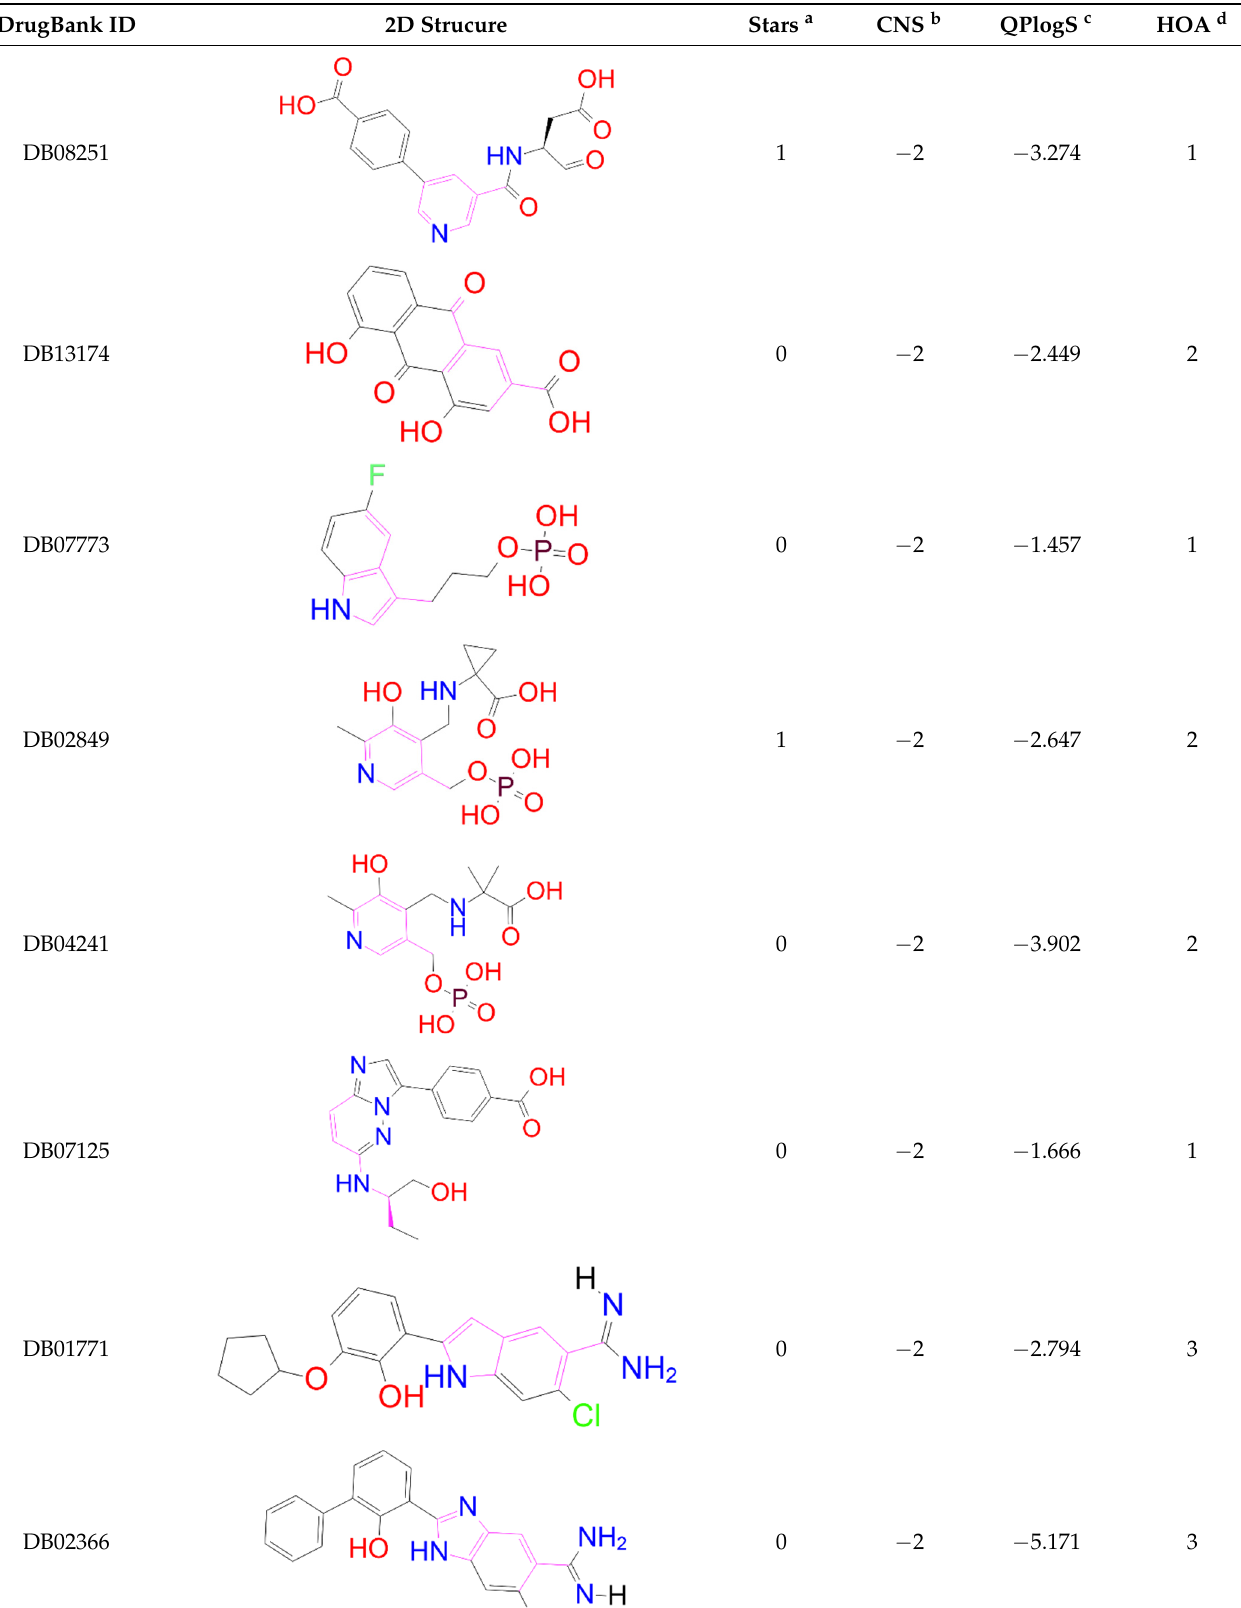
Table 3. 2D structure of hit compounds with their predicted ADME properties.